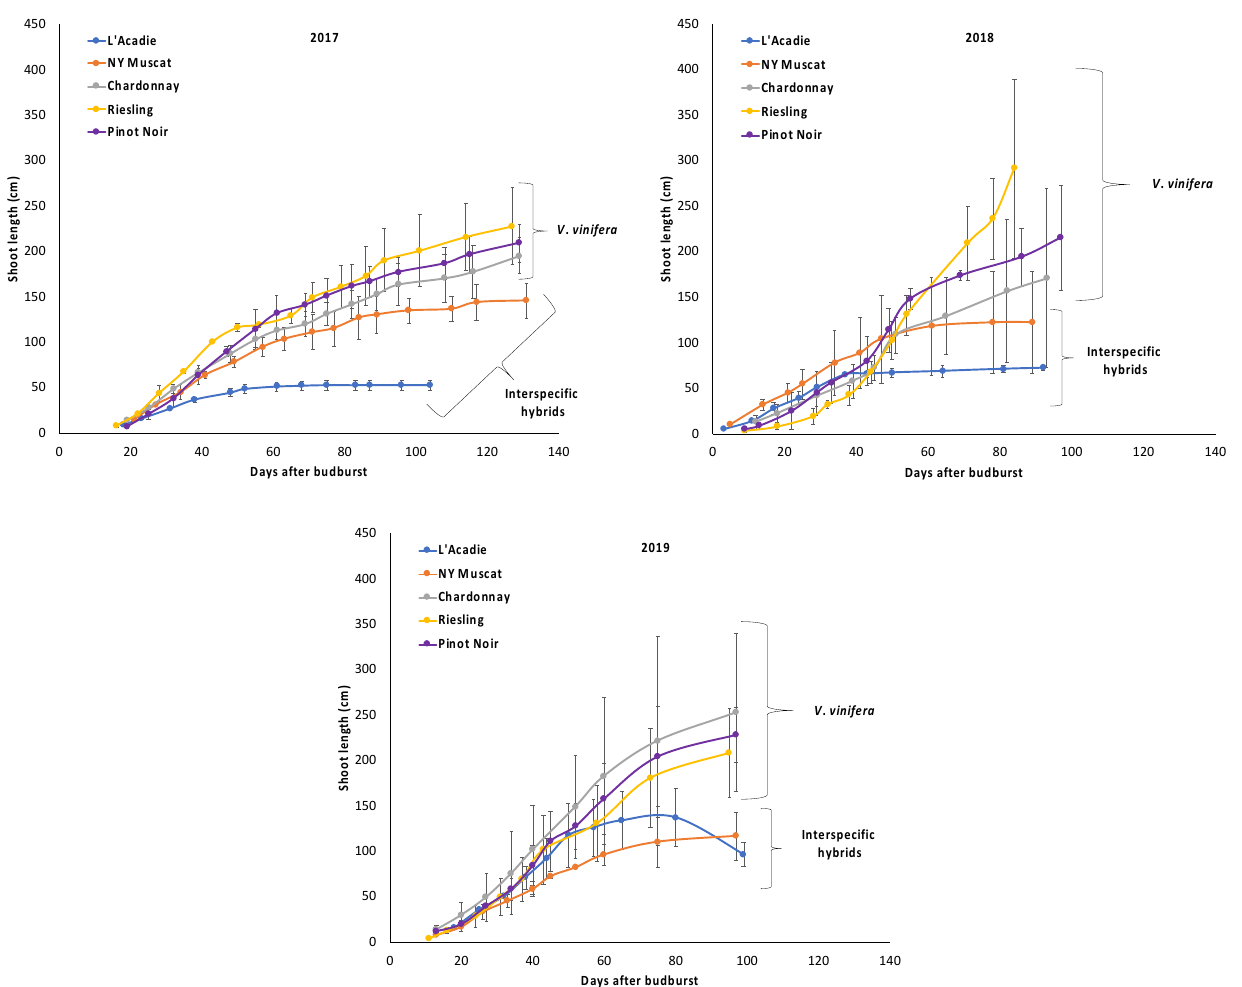
Figure 1. Shoot growth development of cold-hardy interspecific hybrid grapes (L’Acadie and New York Muscat) and Vitis vinifera varieties (Chardonnay, Riesling, and Pinot Noir) after budburst from 2017–2019 seasons. NY: New York.